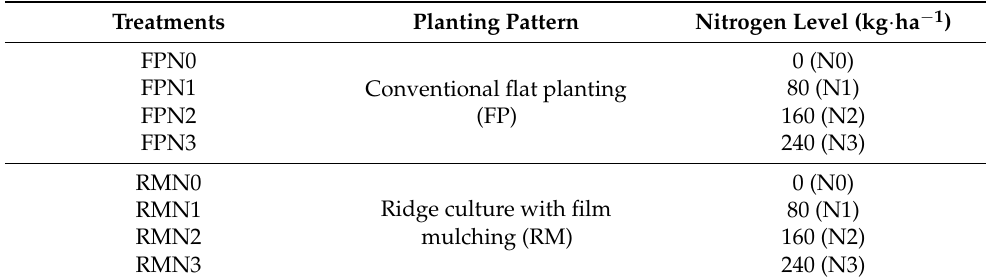
Table 1. Experimental design.